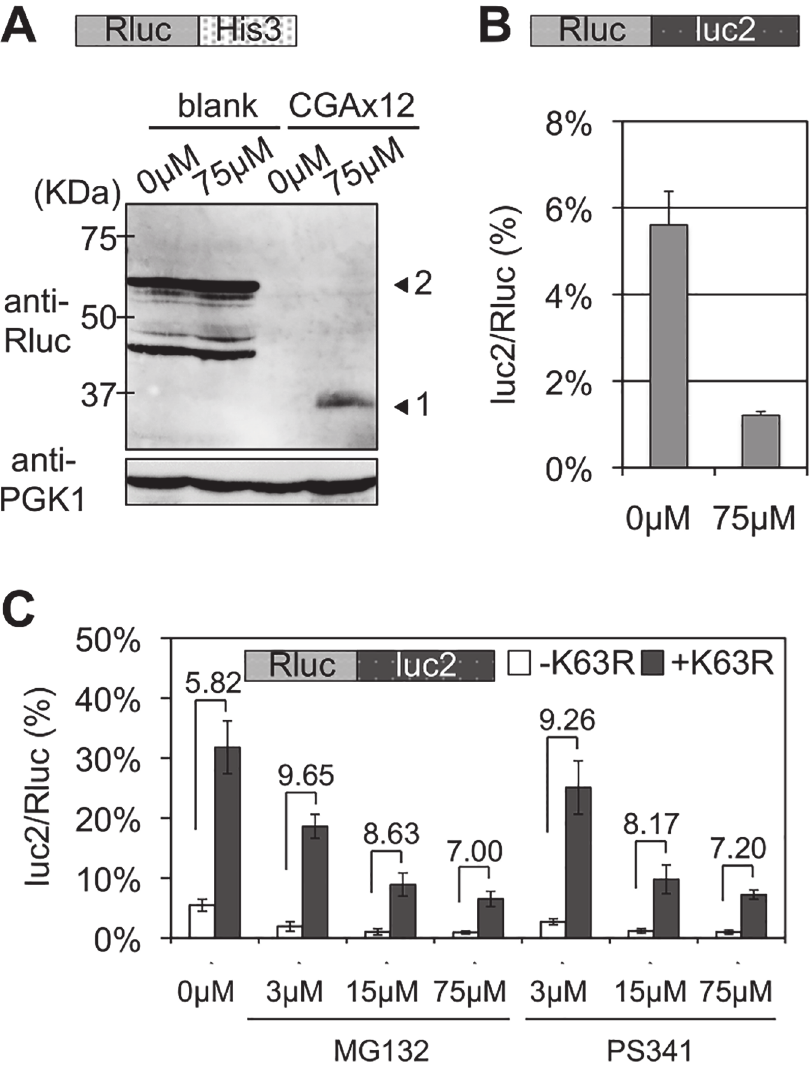
Fig 5. Effects of proteasome inhibitors, MG132 and PS341, on stalled translation and K63R expression. (A) Western blot analysis for effect of MG132. Vectors with Rluc-HIS3 reporters were introduced into a wild-type strain (BY4727). Yeast transformants were incubated for 5 h with either DMSO (e.g., 0 μ M MG132) or 75 μ M MG132. Arrowhead 1 indicates the Rluc protein only and arrowhead 2 indicates the Rluc- blank-HIS3 protein. PGK1 was used as a loading control. (B) Dual luciferase assay for the effect of MG132 on wild-type strain with Rluc-CGA x12-luc2 reporter (HRKW-2). MG132 was used as in (A). (C) The empty or K63R ubiquitin mutation plasmids were introduced into the pdr5 Δ yeast strain harboring Rluc-luc2 reporter (SKY142). The transformants were incubated in the presence of MG132 or PS341 at indicated concentrations for 2 h. Fold differences between the percentages of luc2/Rluc ratios between the transformants with the absence (-K63R) or presence (+K63R) of K63R expression are indicated over the top of the bar